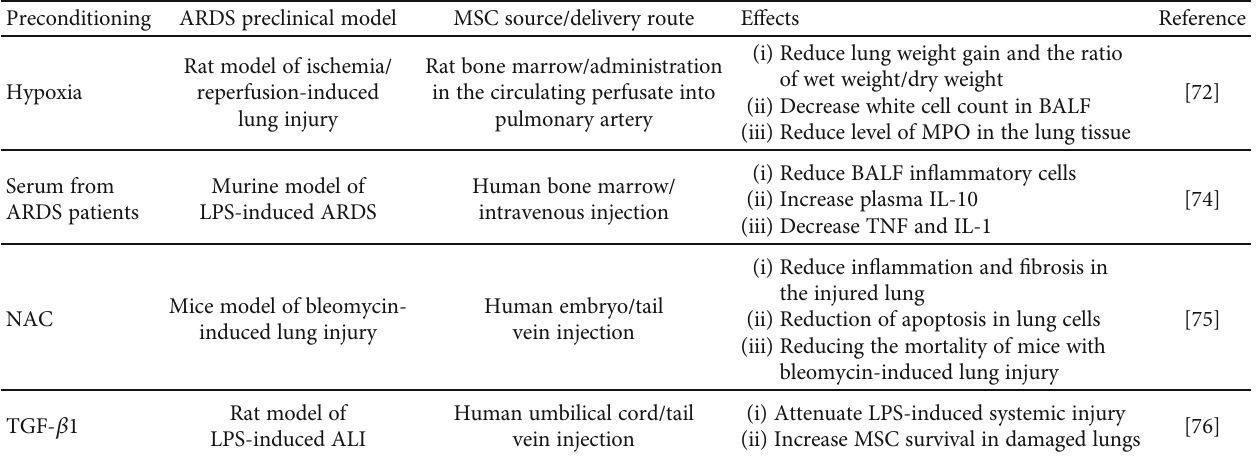
Table 3: Di ff erent preconditioning strategies to improve MSC e ffi cacy in the ARDS preclinical model.